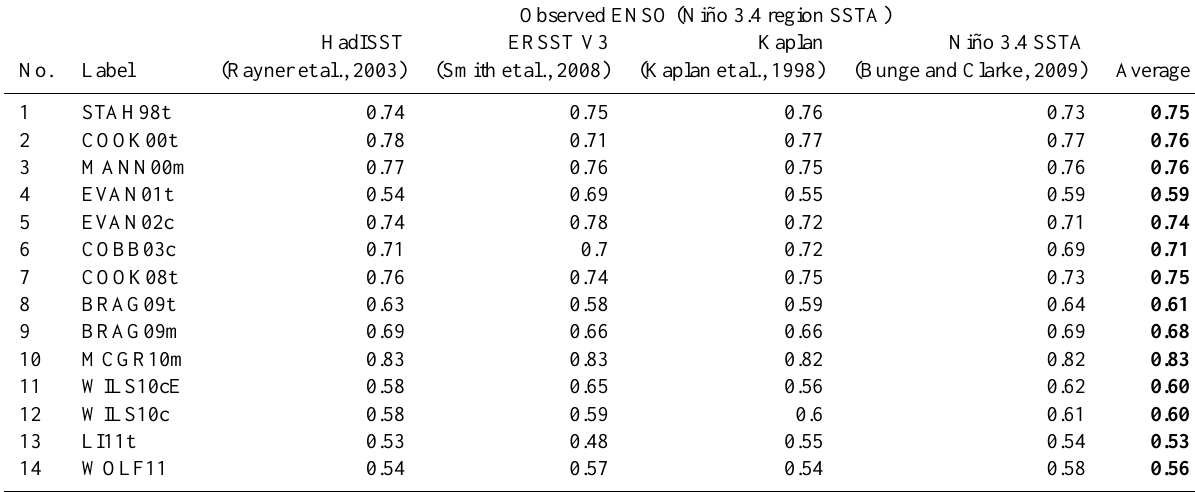
Table 2. Correlation coefficients calculated between the high-pass-filtered (HPF; 10yr cutoff) annual mean proxy-network-based ENSO reconstructions and HPF observed ENSO during the overlapping instrumental period, along with the across observational product average displayed in bold font. All correlations are statistically significant above the 99% level. We note that this measure of statistical signifi- cance takes into account serial (auto-)correlation in the series, based on the reduced effective number of degrees of freedom outlined by Davis